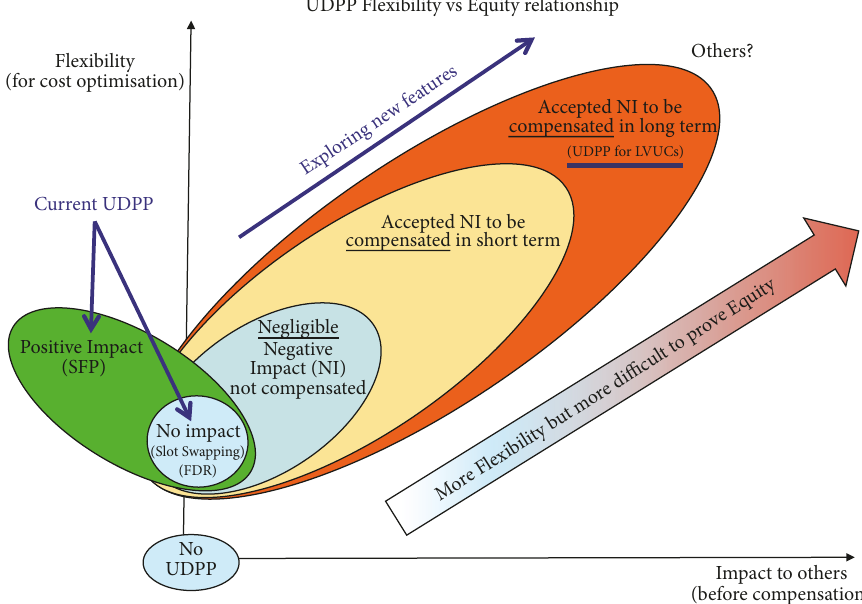
Figure 5: Conceptual relationship between flexibility and